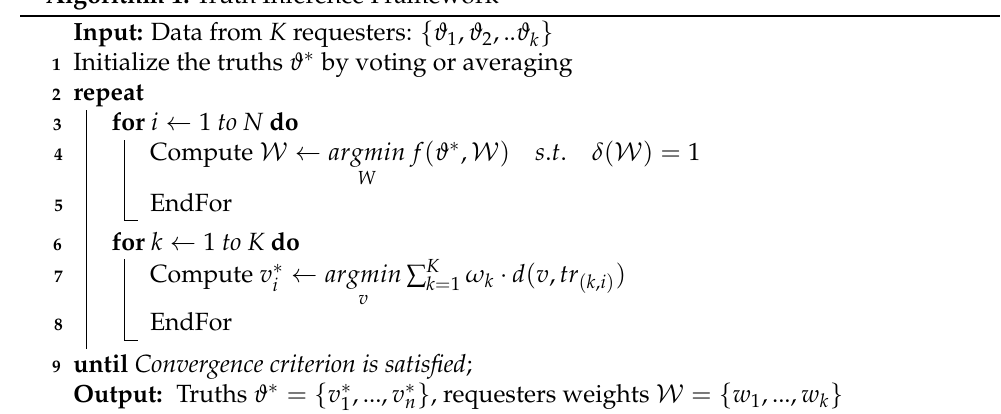
Algorithm 1: Truth Inference Framework